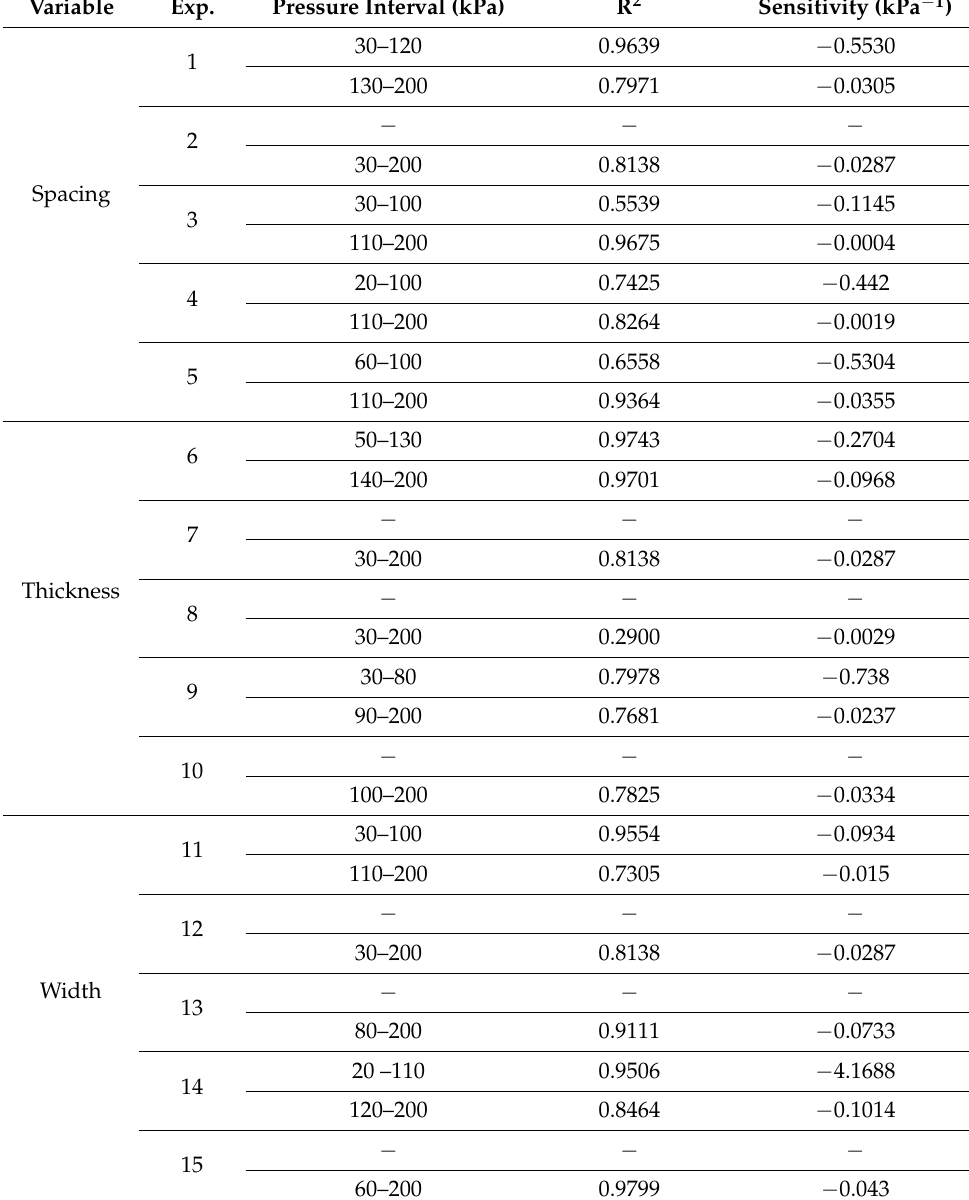
Table 6. Linear regression analysis for different grid